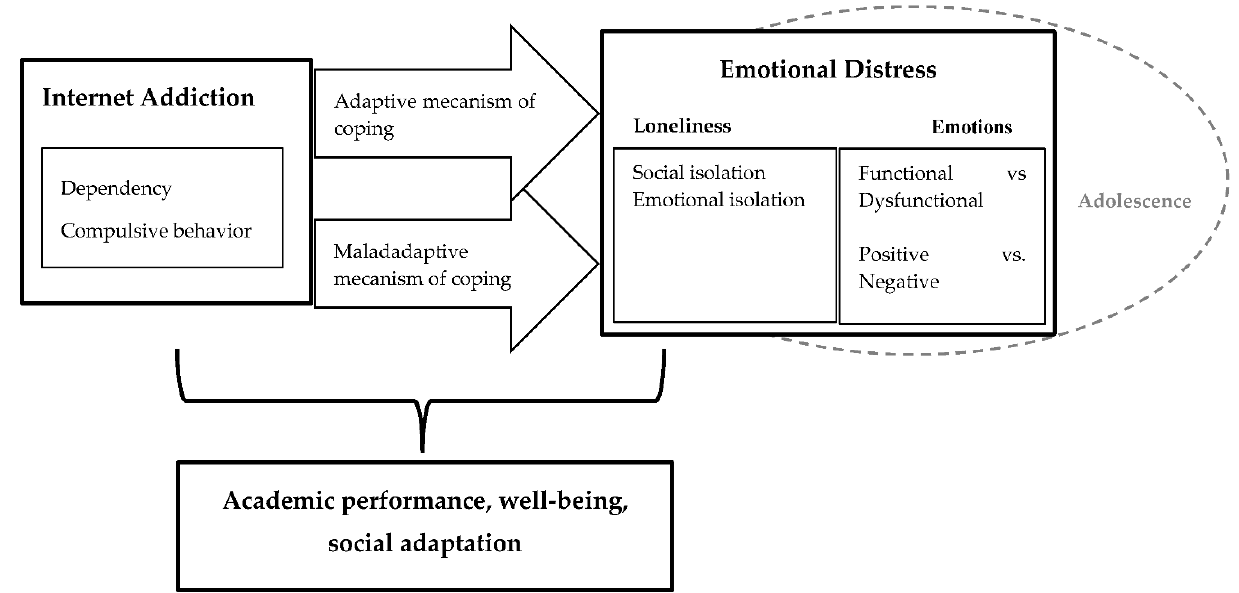
Figure 1. Proposed theoretical model.